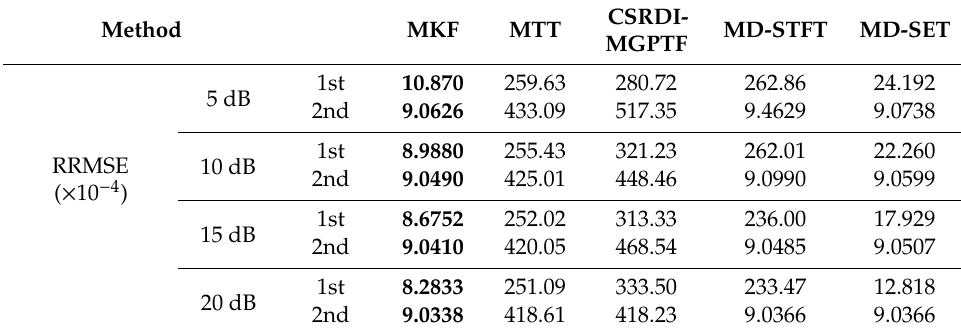
Figure 7. TF spectrums and IF estimation results for example 2 with SNR = 5 dB. ( a ) TF spectrum acquired by STFT; ( b ) TF spectrum acquired by SET. ( c ) MKF; ( d ) MTT; ( e ) CSRDI-MGPTF; ( f ) MD-STFT; ( g ) MD-SET. Table 3. Performance evaluation of IF Estimation for example